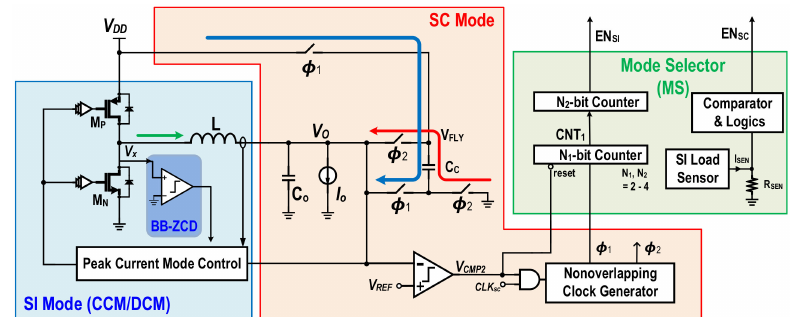
Figure 3. Overall architecture of the proposed triple-mode SIC dc-dc buck converter.